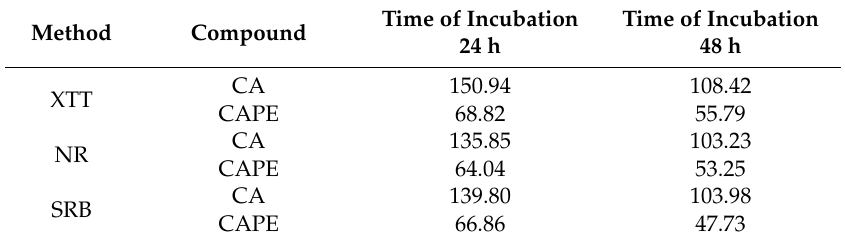
IC 50 ( µ M) values of caffeic acid (CA) and caffeic acid phenethyl ester (CAPE) in relation to breast cancer MDA-MB-231 for 24 h and 48 h, using different methods (XTT, NR, SRB, respectively: 2,3-bis[2methoxy-4-nitro-5-sulfopheny]-2H-tetrazolium-5-carboxyanilide inner salt, neutral red, Sulforhodamine B). All data demonstrated that lower doses of CAPE (ca. twice as low as CA) are needed to receive a similar mortality effect on MDA-MB-231